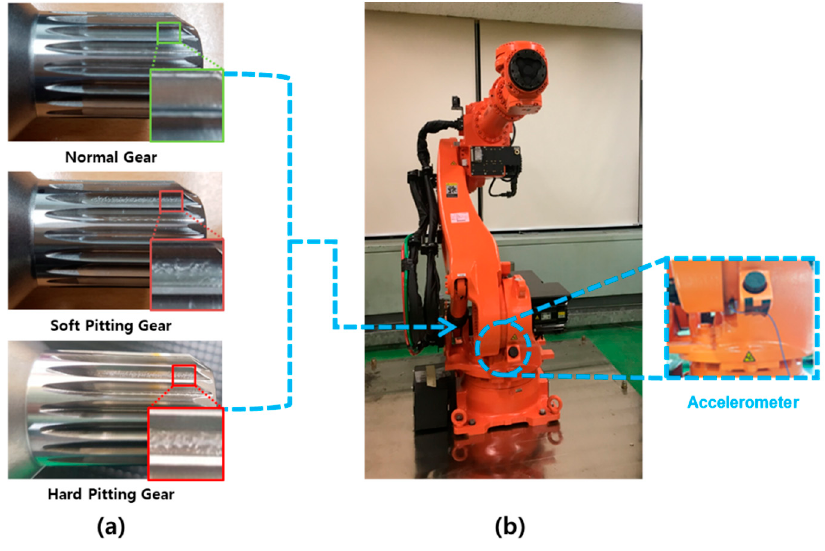
Figure 6. ( a ) Three different types of input gear at second joint, and ( b ) HS-180 manipulator and position of accelerometer.